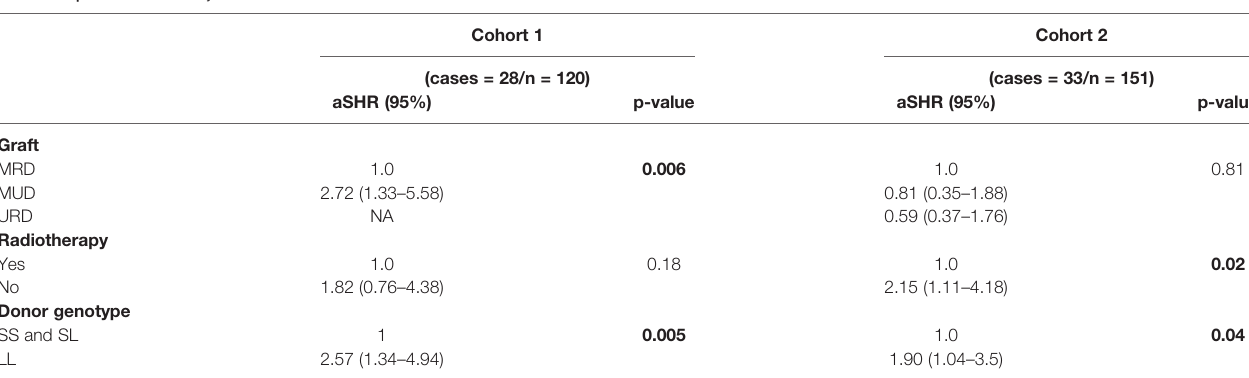
TABLE 7 | Multivariate analysis of GVHD risk factors.